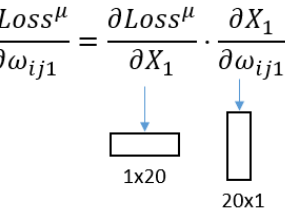
Figure 6. Component sizes, taking the lattice from the output layer.